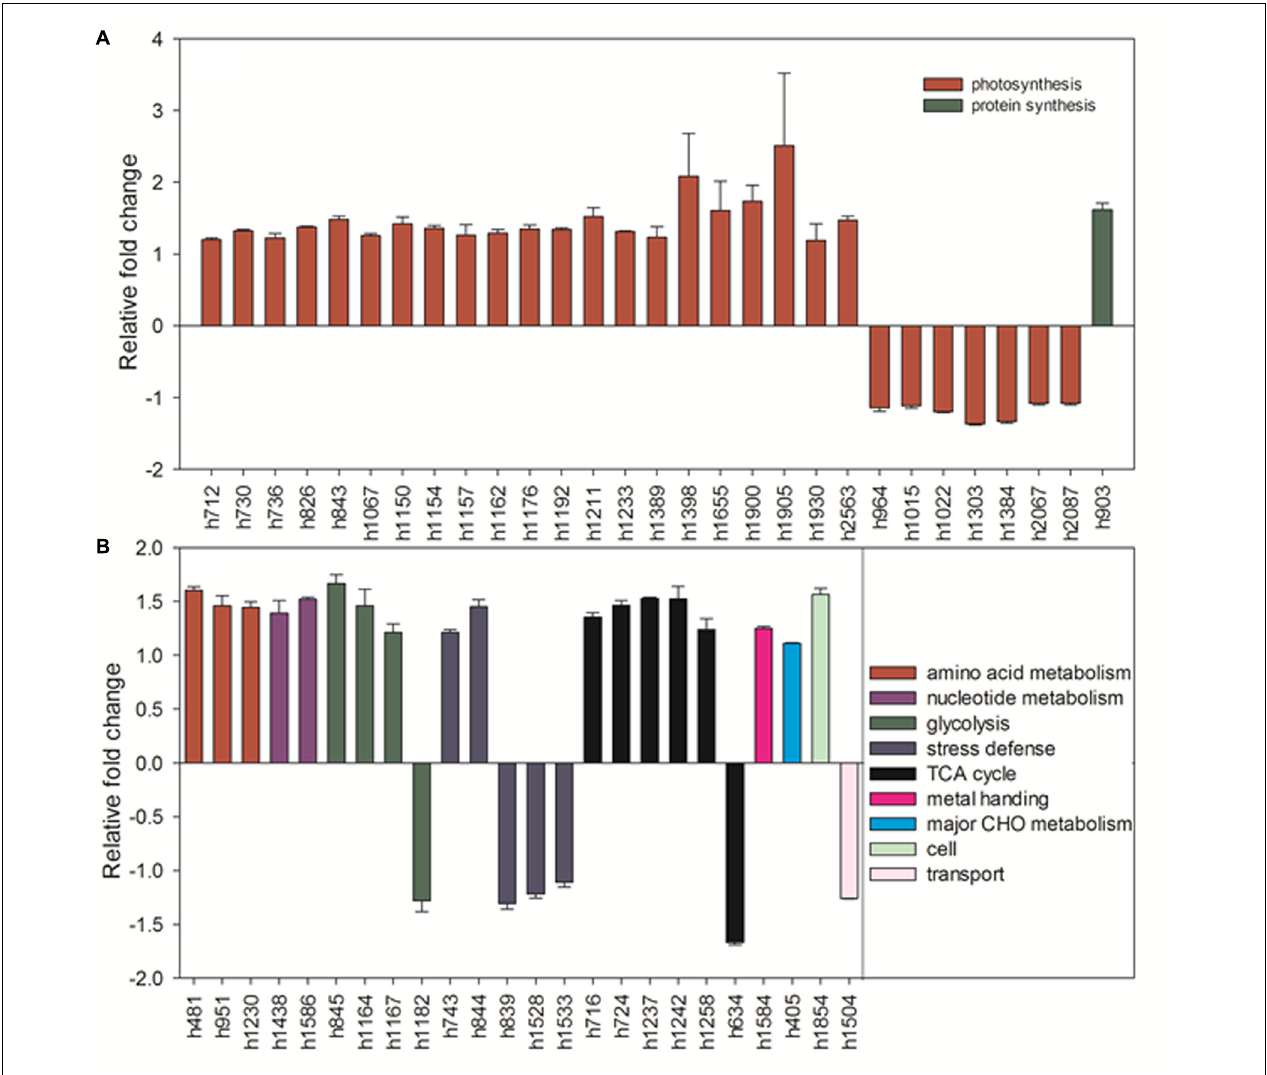
FIGURE 15 | Comparison of protein abundance caused by elevated CO 2 (800 µ mol · mol − 1 ) with ambient CO 2 (400 µ mol · mol − 1 ) under heat stress (45 ◦ C). Charts are organized by the functional category of proteins involved in photosynthesis and protein synthesis as shown in (A) as well as amino acid metabolism, glycolysis, stress defense, TCA cycle, metal handing, major CHO metabolism, cell and transport as shown in (B) . The values of the mean ± SE represent the relative expression fold change of proteins in response to elevated CO 2 under heat stress. Labels with ‘h’ in X-axle were same as Table 2